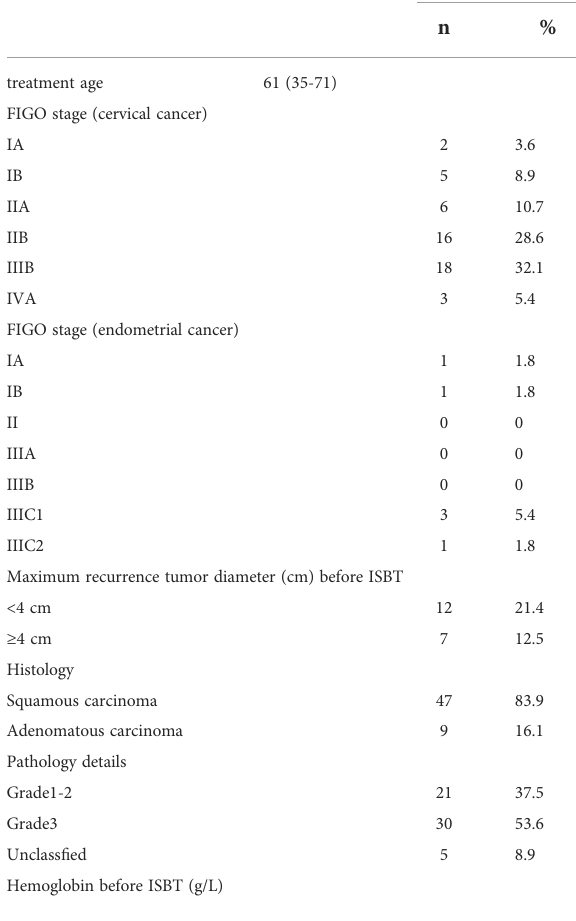
TABLE 1 Patient